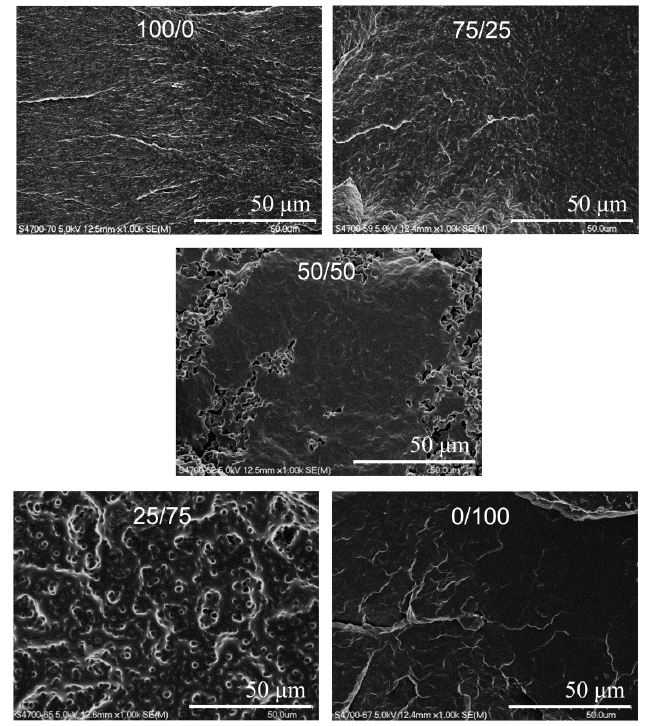
Figure 5. FE-SEM images of the fractured surfaces of PEU-3scLAO/2CLOs (100/0, 75/25, 50/50, 25/75 and 0/100).